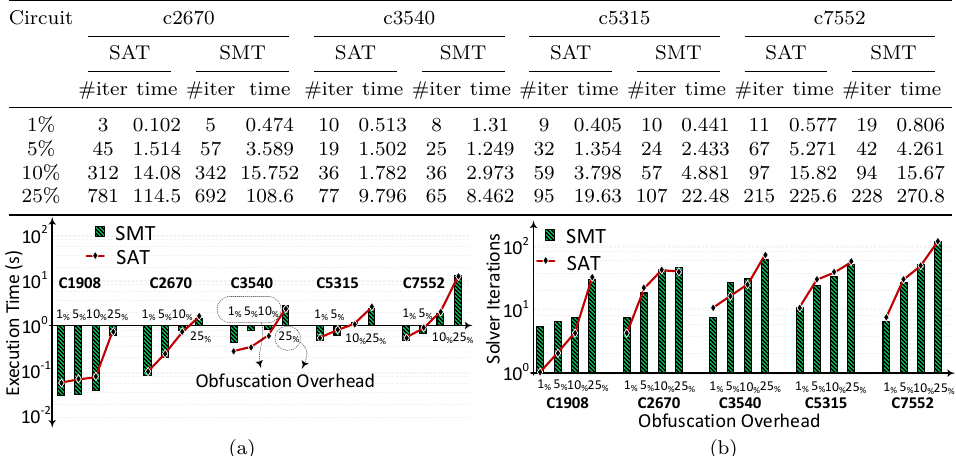
Figure 11: Comparing the Performance of SMT-attack when Reduced to a SAT Attack (Attack Mode 1) with that of original SAT-attack that uses Lingling solver [SRM15]. The ISCAS-85 Benchmarks are obfuscated using IOLTS’14 Insertion [DBDN + 14]: (a) Comparison of the Execution Times, (b) Comparison of the Number of